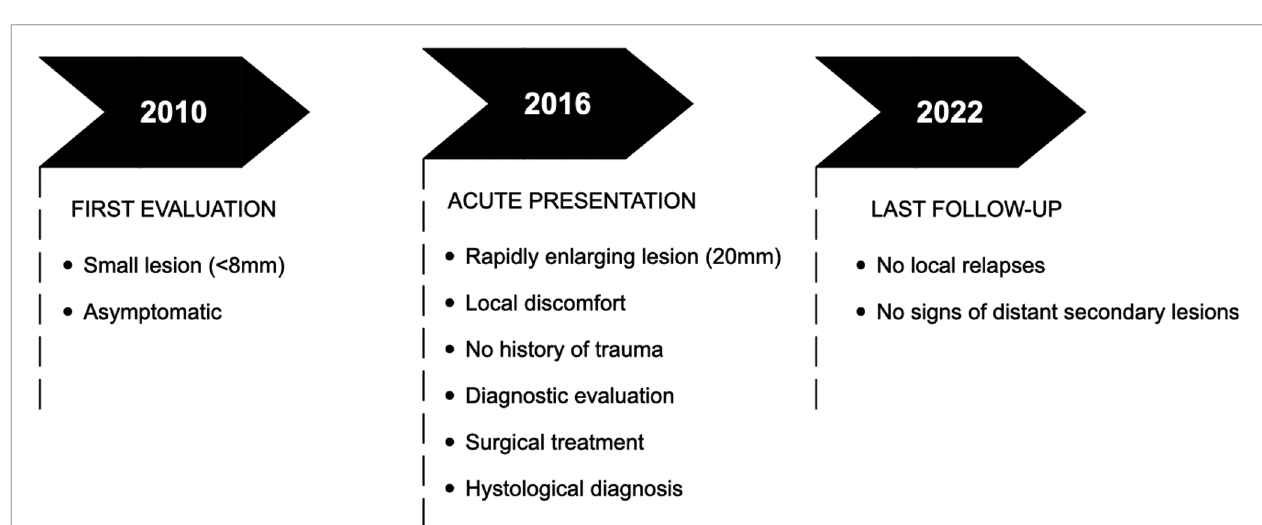
FIGURE 4 | Timetable reporting relevant data from the episode of care.